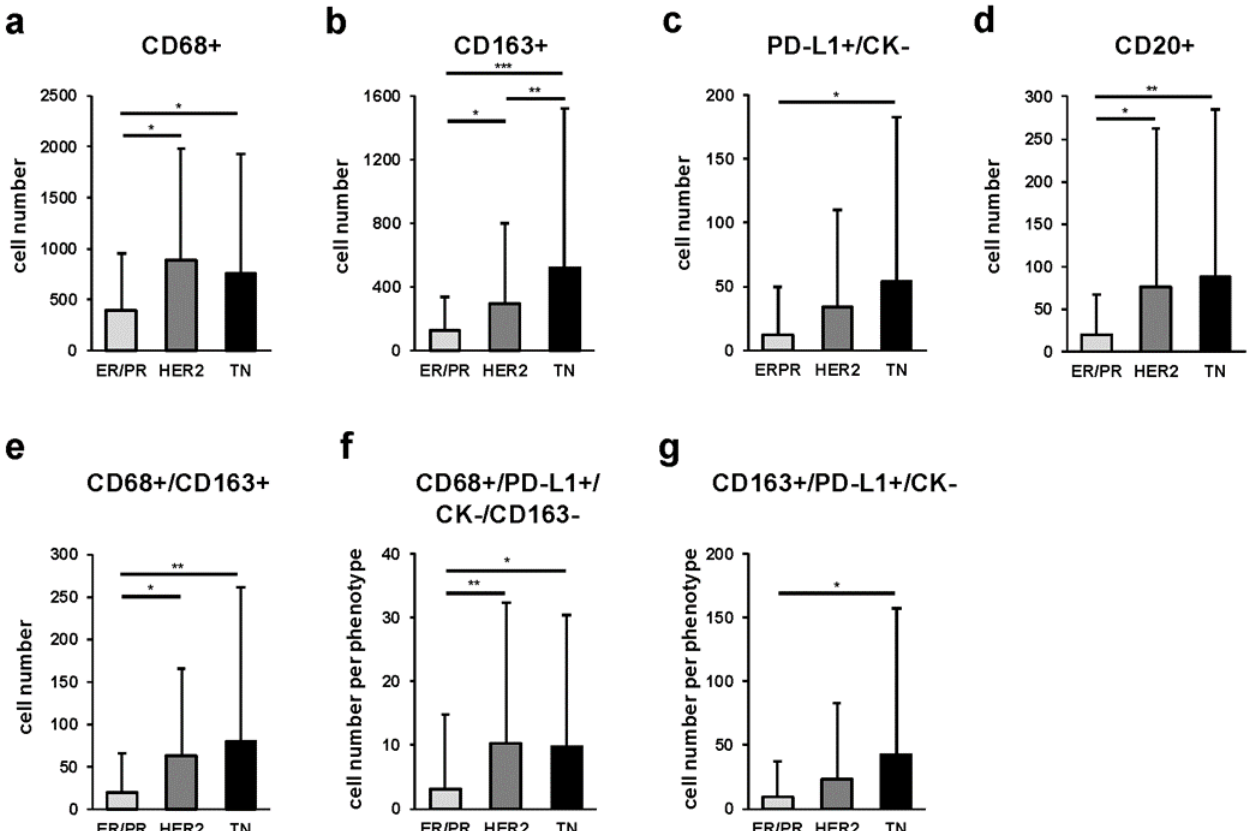
Figure 4. Comparison of single- and multiple-stained intratumoral TAMs (iTAMs), immune modifi- cation, and B-cell-marker-positive cells among ER/PR, HER2, and TN subtypes. Average number of single-marker-positive cells: ( a ) CD68+ (* indicates p < 0.001), ( b ) CD163+ (*, ** and, *** indicate p = 0.048, p = 0.021, and p = < 0.001, respectively), ( c ) PD-L1+ (* indicates p < 0.001), and ( d ) CD20+ (* and ** indicates p = 0.003 and p < 0.001, respectively) cells. Average number of multiple-marker- positive cells: ( e ) CD68/CD163 double-positive (* and ** indicate p = 0.005 and p < 0.001, respec- tively), ( f ) CD68+/PD-L1+/CK-/CD163- (* and ** indicate p = 0.004 and p = 0.002, respectively), and ( g ) CD163+/PD-L1+/CK- (* indicates p < 0.001) iTAMs per 1 mm 2 at 5 locations in each subtype; p -value was calculated using one-way ANOVA test and Tukey’s multiple comparison test. Error bars represent standard deviation.